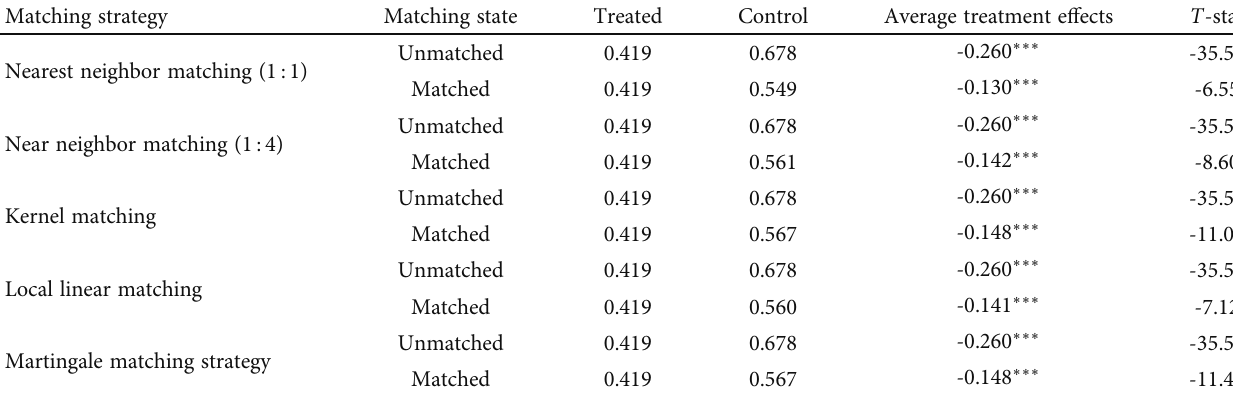
Table 4: Impact of Internet usage on gender division of labour bias.